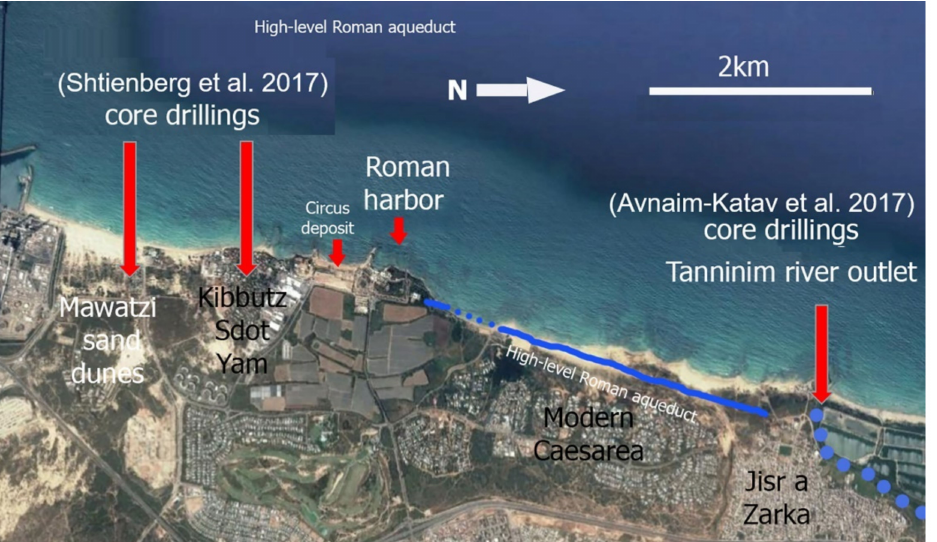
Figure 15. Location of boreholes taken in coastal lowlands few kilometers south of the Caesarea harbor [91], and in Tanninim river outlet, few km north of the Caesarea harbor [92], and location of the Roman circus fill deposit (Modified by E. Galili after Google